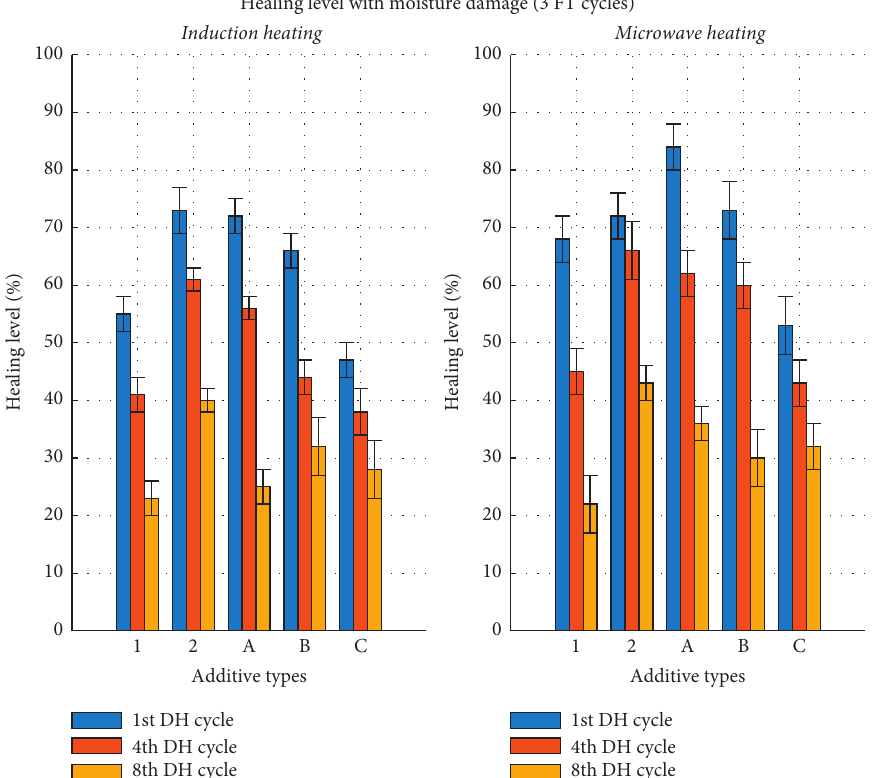
Figure 10: Healing level of unaged mixtures with moisture damage (3 FT